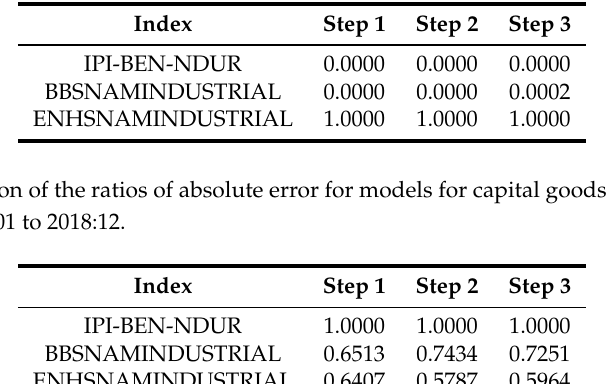
Table 15. Model confidence set hierarchy loss function is the squared error at the end of the sample for non-durable goods model comparison α = 0.05, number of bootstrap replications = 5000 and block length = 12. The null hypothesis is that the average performance of the model in the row is as small as the minimum average performance across the remaining models. The alternative is that the minimum average loss across the remaining models is smaller than the average performance of the model in the row.